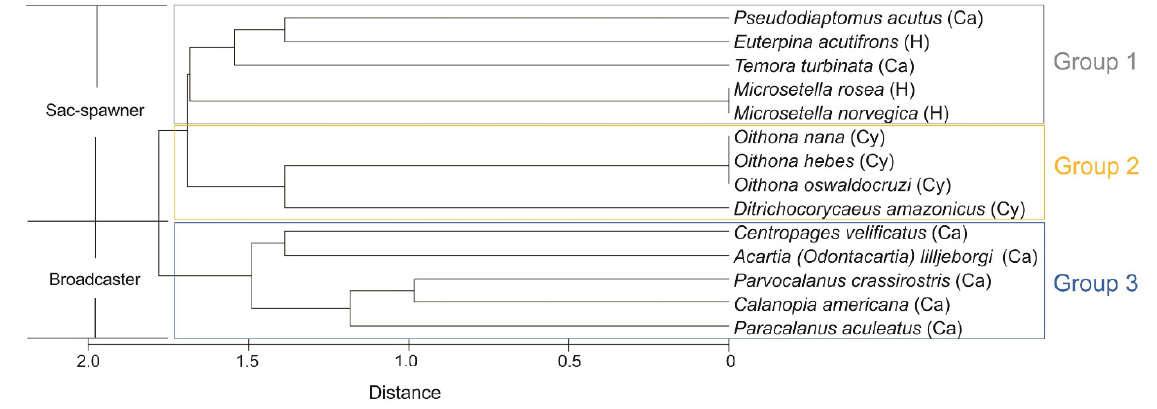
Figure 7. Identification of the functional groups of copepods in Piranji Estuary (equatorial Southwestern Atlantic, Brazil) during an intense drought period (year 2015). Groups 1 and 2: sac spawners. Group 3: broadcasters. Ca: Calanoida. Cy: Cyclopoida. H: Harpacticoida.